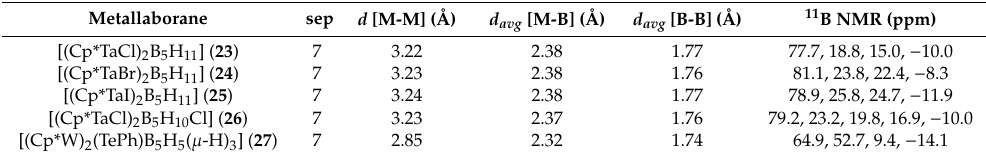
Table 4. Skeletal electron pair count (sep), selected structural parameters and 11 B NMR chemical shifts of 23 – 27 .